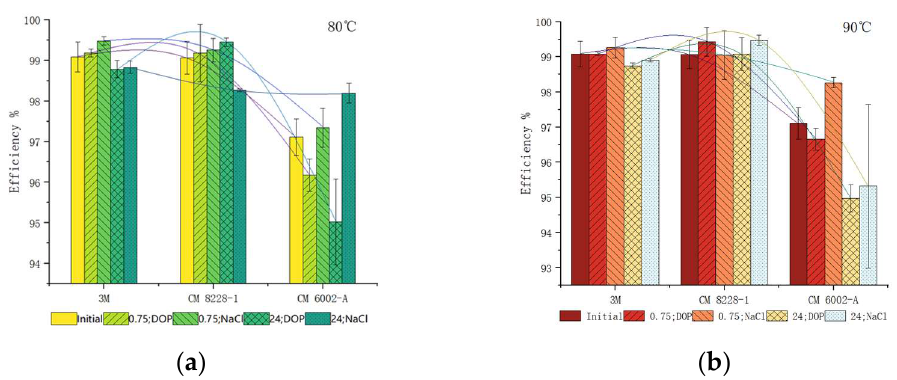
Figure 9. ( a ) The DOP particles and NaCl particles filtration efficiency at 80 °C for 0. 75 h and 24 h, respectively. ( b ) The DOP and NaCl particle filtration efficiency at 90 °C for 0. 75 h and 24 h, respectively.